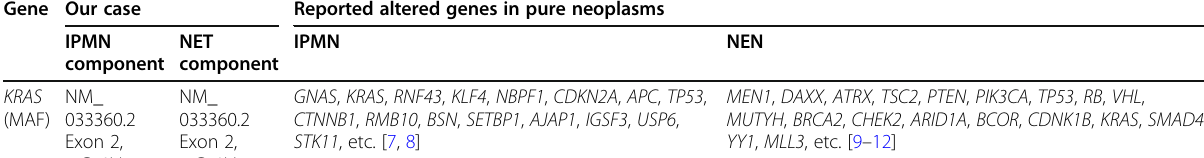
Table 1 Genetic alterations of our case and comparison with pure neoplasms Gene Our case Reported altered genes in pure neoplasms